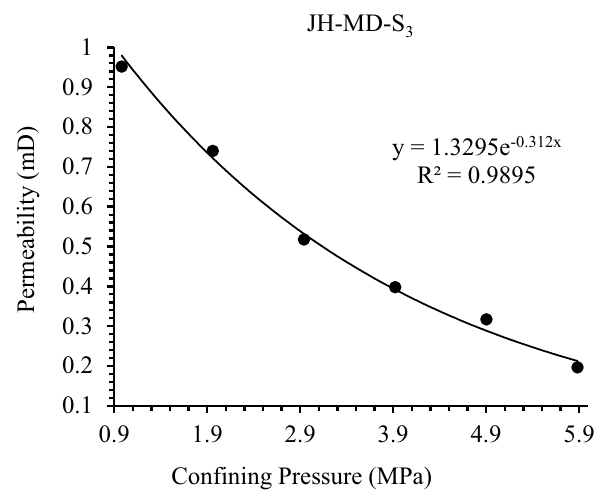
y = 1.3295e -0.312x